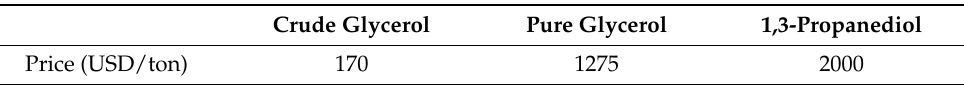
Table 1. Glycerin technology of economic value. The market price of crude glycerol, pure glycerol, and 1,3-propanediol